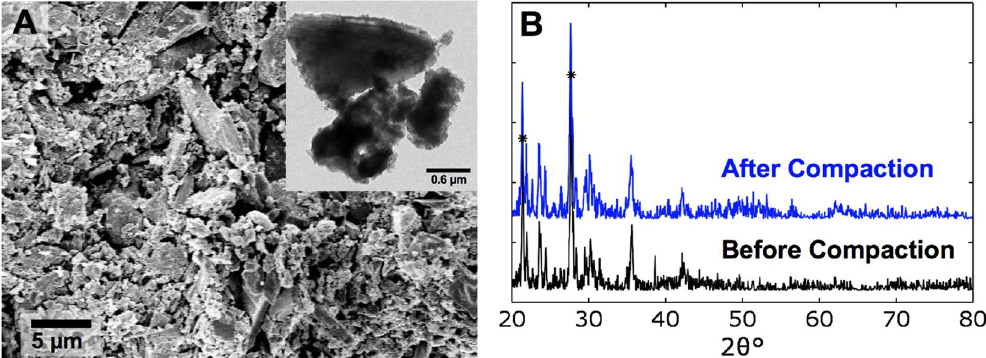
Figure 2. ( A ) SEM image of a solid Mars-1a fracture surface. The inset displays a TEM image of several basaltic grains bonded together; fuzzy and diffuse areas on the exterior of each particle are indicative of npOx, and the contact suggests npOx binding. The material had the initial particle size of 25–45 μ m, and was compressed under 360 MPa quasi-statically with flexible boundary condition; the compression pressure was oriented horizontally in the SEM image. ( B ) Typical XRD curves of reference Mars-1a and solid Mars-1a compressed to 360 MPa with flexible boundary condition. Asterisks indicate the two main peaks of the bottom